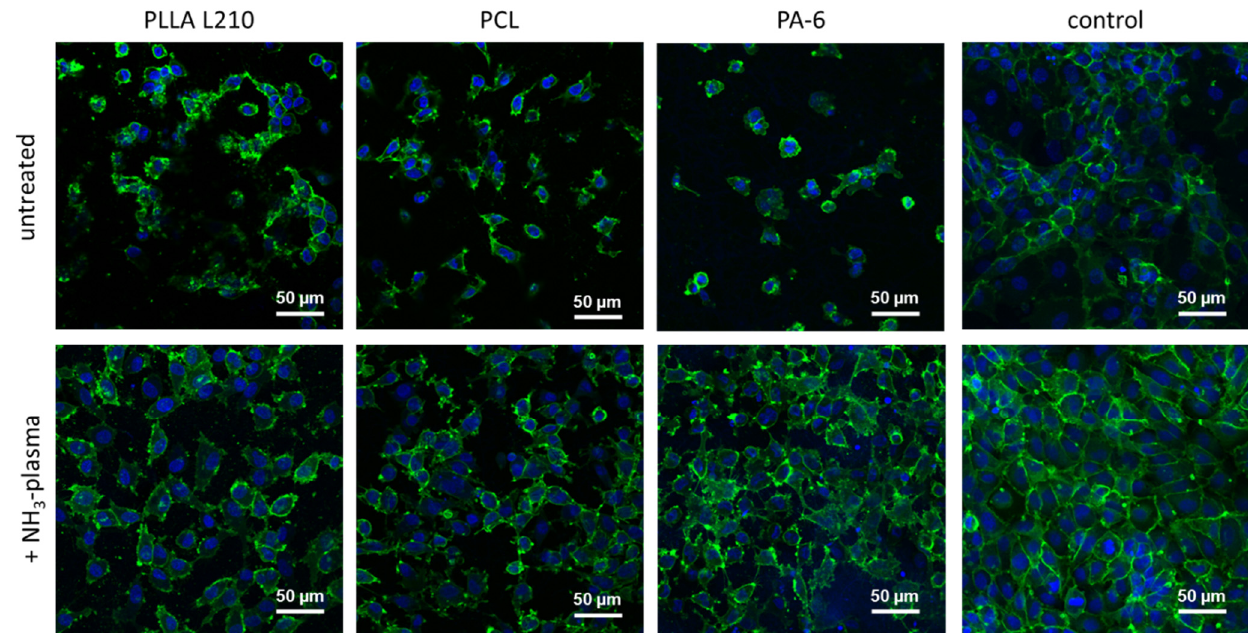
Figure 11. Immunostainings of CD31 in human endothelial EA.hy926 cells on unmodified and NH 3 - plasma functionalized polymeric nonwovens after 48 h (green: CD31, blue: Hoechst-staining indicating cell nuclei, confocal microscopy, and bar = 50 µm).